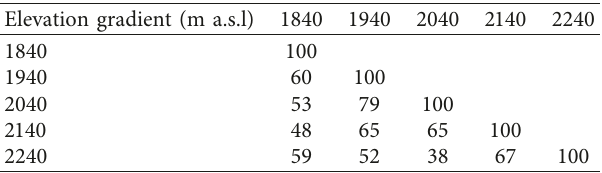
Table 1: Sørensen’s similarity index (%) of species along elevation gradients of coffee-based agroforestry